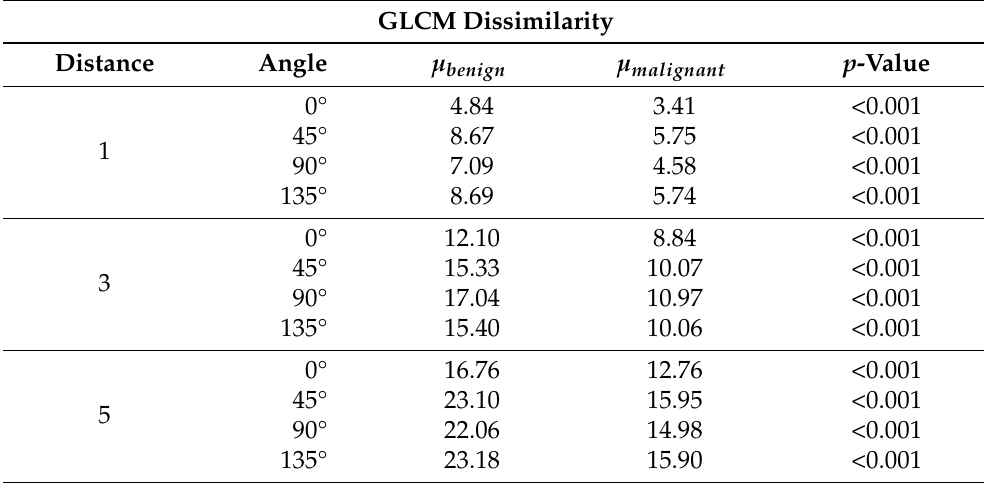
Table A5. The gray level co-occurrence matrix dissimilarity feature measured across three pixel